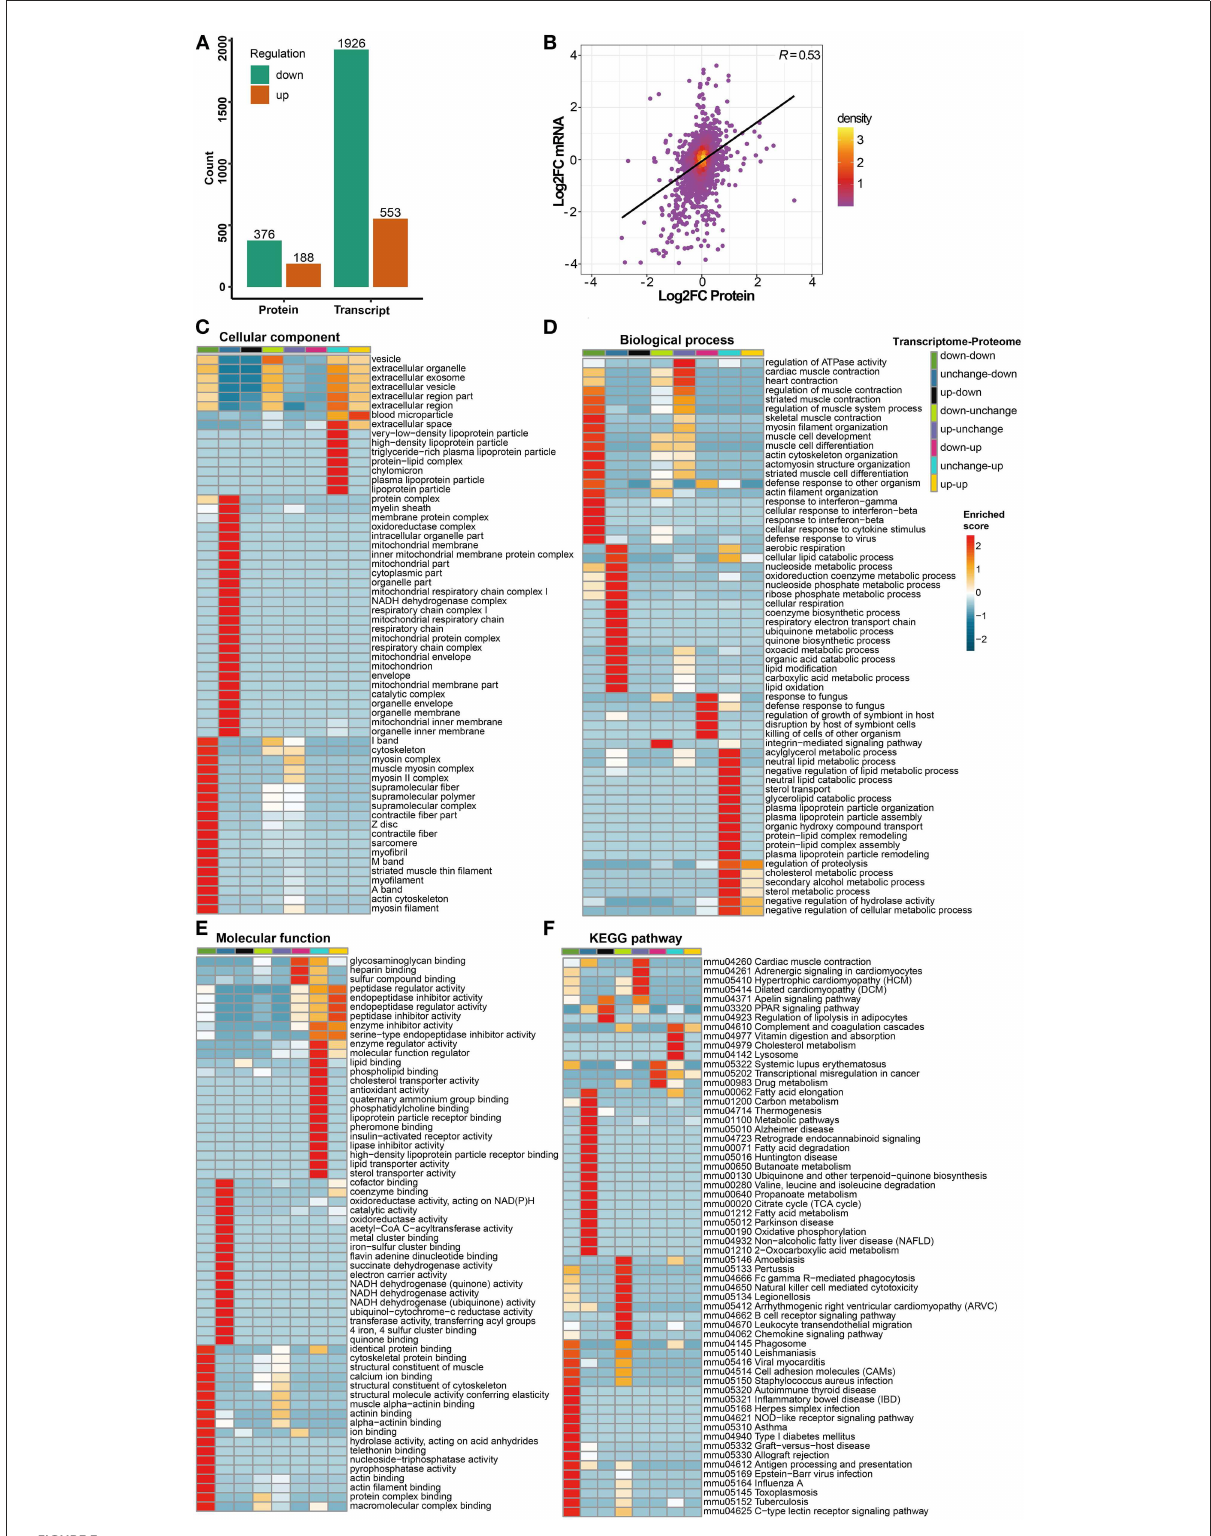
FIGURE3 Transcriptomics and proteomics associative analysis. (A) Number of differentially expressed genes and proteins in transcriptome and proteome. Green means significantly downregulated genes and proteins, orange means significantly upregulated genes and proteins. (B) Scatterplot of transcript and its corresponding protein expression. The horizontal axis shows the protein expression and the vertical axis shows the transcript